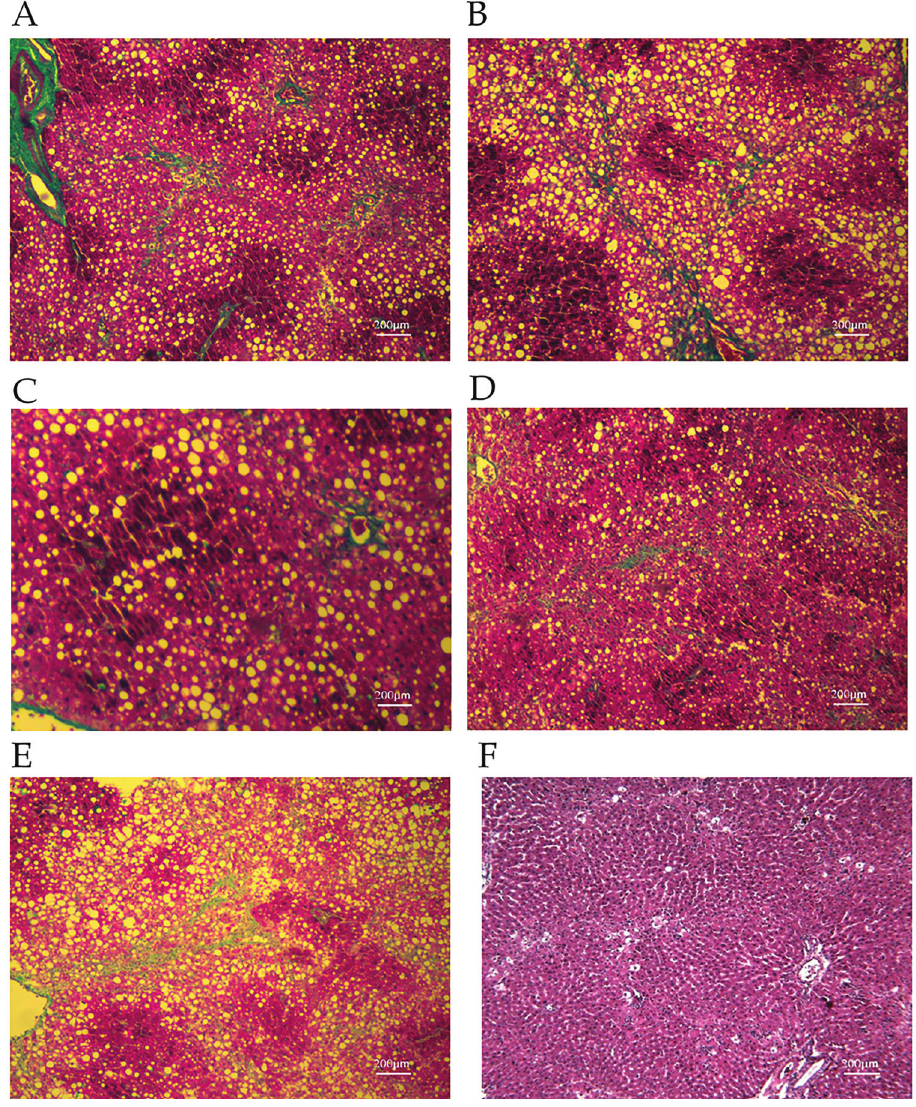
Figure 4. Pathological images of A , control (moderate and severe fi brosis, thick fi brous septae of the false lobule, heavy degree of hepatocyte degeneration and necrosis, and a lot of fat vacuoles); B , bone marrow mesenchymal stem cells (BMSCs); C , BMSCs + granulocyte colony-stimulating factor (G-CSF); D , BMSCs + Jisheng Shenqi decoction (JSSQ); E , JSSQ; F , normal groups (no obvious hepatic fi brosis, degeneration and necrosis of hepatocytes, and a little fatty degeneration) (H&E and Masson staining, bar 200 m